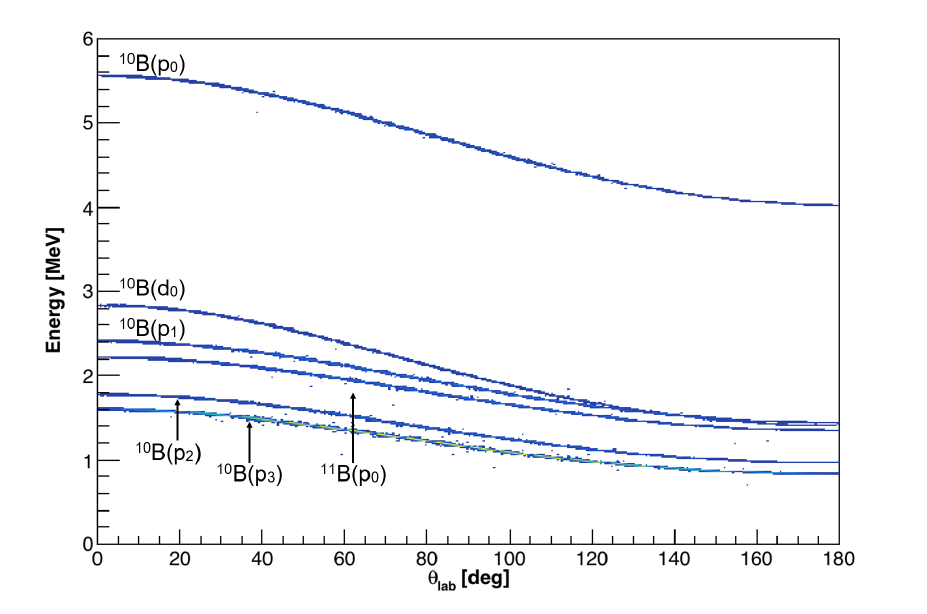
Figure 5: Out-going particle energy versa emitted angle θ . Here, 10 B ( p 10 B ( p 10 B ( p 10 B ( p 0 ) , 1 ) , 2 ) , 3 ) denote proton produced by the reaction